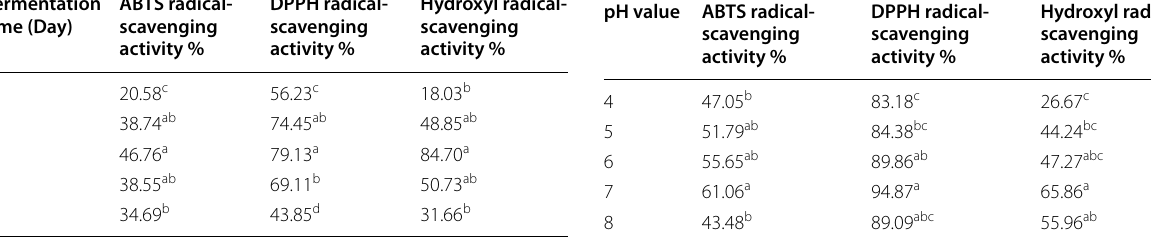
Where the data are the means of triplicate experiments; samples in the same column with different superscript letters are significantly different (P < 0.05). a value is the highest antioxidant activity, b value is the medium antioxidant activity and c value is the lowest antioxidant activity in the same